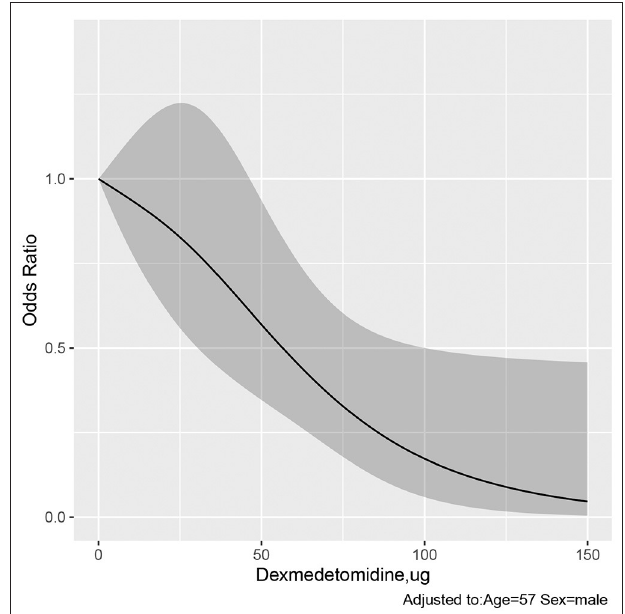
FIGURE 2 | Dose–response relationship of dexmedetomidine and PONV. The ordinate is the odds ratio (0–1), and the abscissa is the dosage of DEX (0–150 µ g). Error bars represent 99% confidence intervals. The larger the dose of DEX is, the lower the incidence of PONV. DEX, dexmedetomidine; PONV, Post-operative nausea and